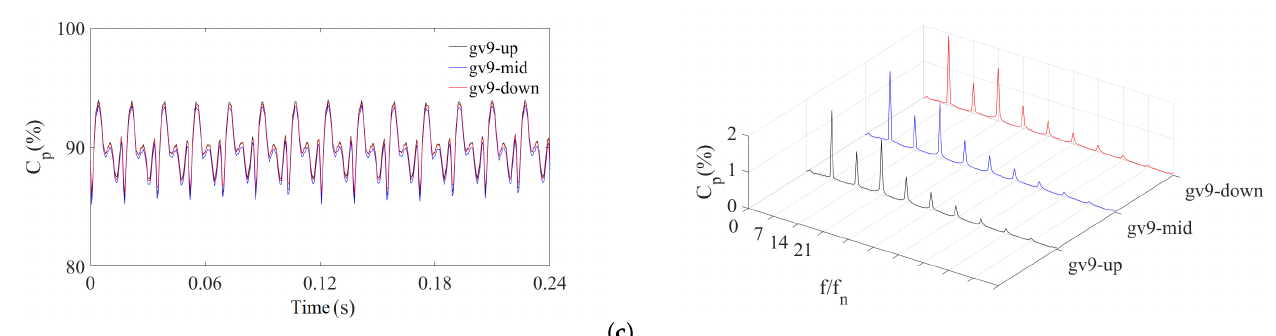
Figure 15. Time–domain and frequency–domain diagrams of pressure fluctuations of the monitoring points along with the vertical height. ( a ) 60% load condition. ( b ) 86.7% load condition. ( c ) 100% load condition.